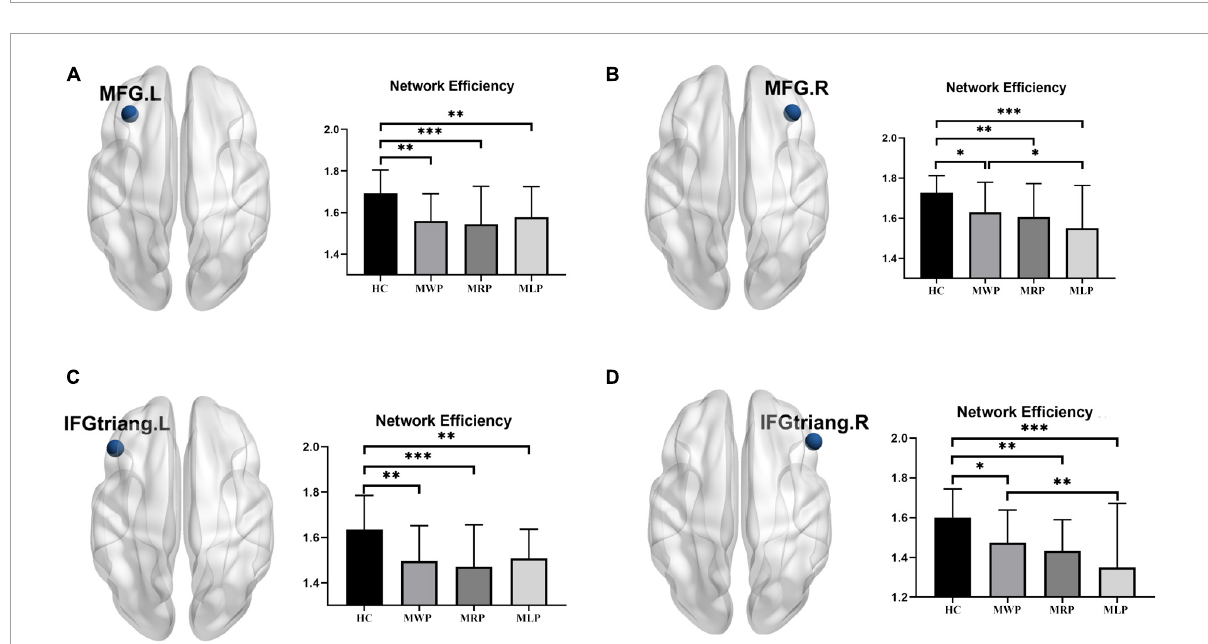
FIGURE5 Comparison of nodal efficiency in the local network. In comparison with the healthy controls (HCs), MMD patients without paresthesia (MWP), patients with right-limb paresthesia (MRP), and patients with left-limb paresthesia (MLP) showed reductions in nodal efficiency in the following brain regions: MFG.L (A) : MLP > MWP > MRP; MFG.R (B) : MWP > MRP > MLP; IFGtriang.L (C) : MLP > MWP > MRP; and IFGtriang.R (D) :MWP > MRP > MLP;. The asterisk (*) denotes results without family-wise error (FWE) correction, ** p < 0.05 after FWE correction, and *** p < 0.01 after FWE